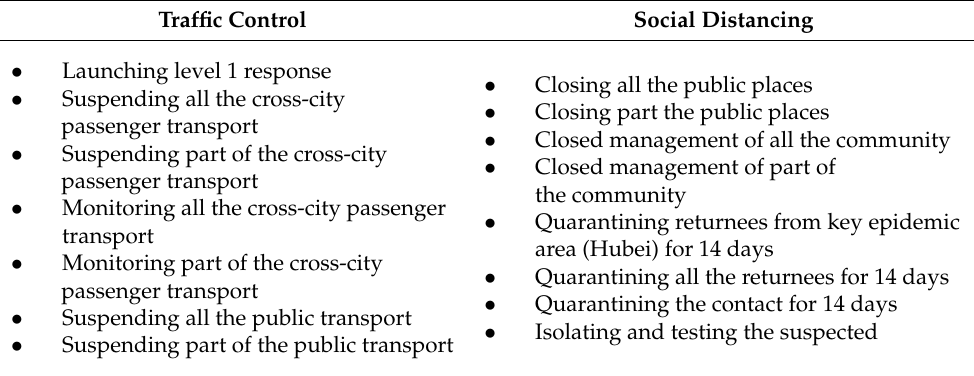
Table 1. Items of traffic control and social distancing.